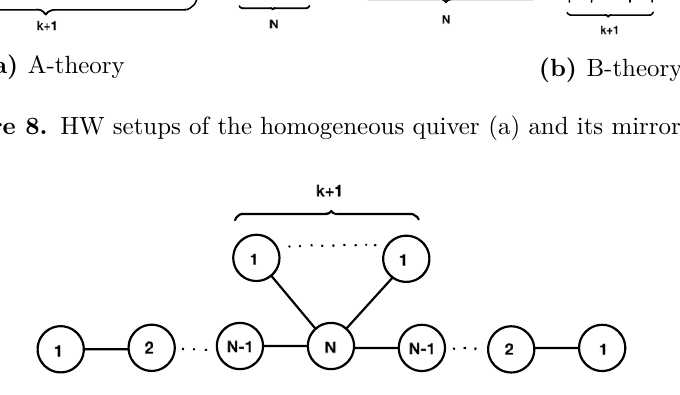
Figure 9. Mirror dual of homogeneous linear